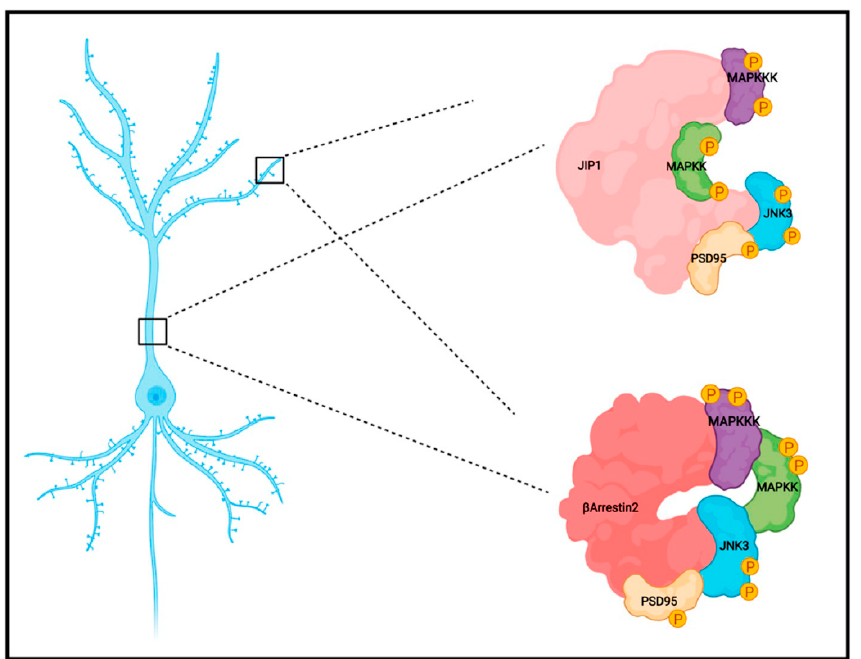
Figure 6. Schematic representation of the protein–protein interactions mediated by JIP1 and b-arrestin2 scaffold proteins. Both scaffold proteins bind upstream MAPK activators, PSD95 and JNK3, thus regulating the signaling cascade in subcellular compartments.